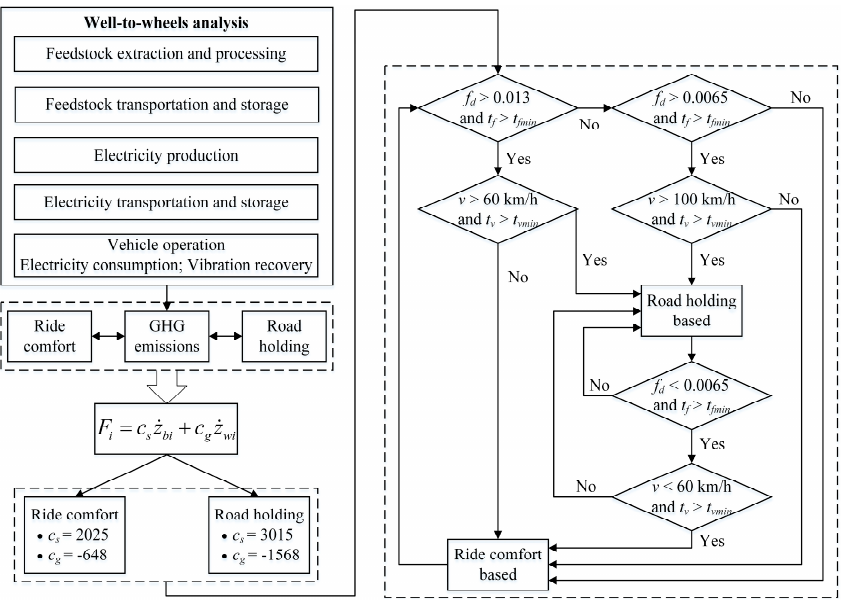
Figure 4. Control scheme of regenerative suspension.